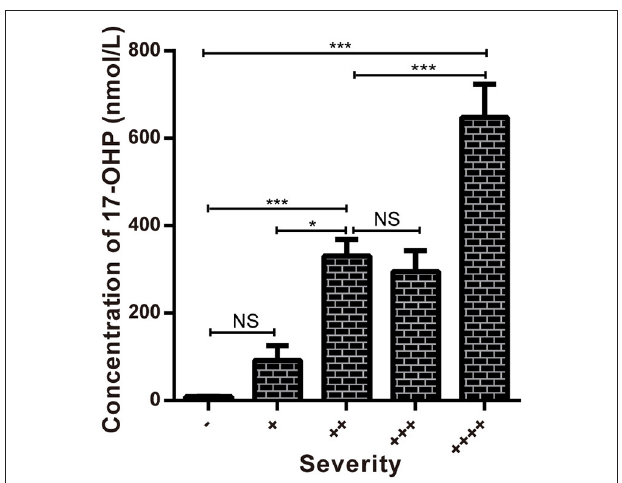
FIGURE 4 | Comparison of the concentrations of 17-OHP in different severity groups. * P < 0.05 *** P < 0.001; NS, no